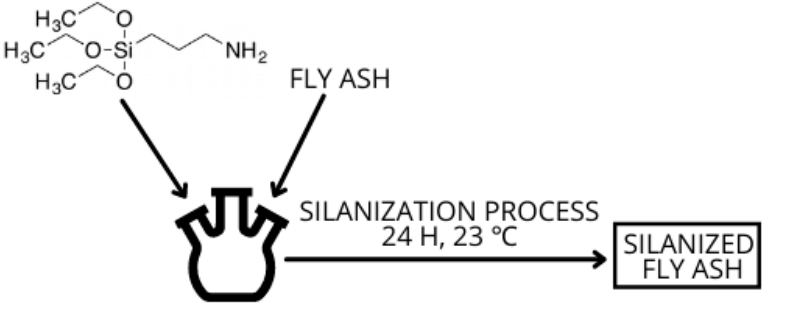
Figure 2. Scheme of silanization process.